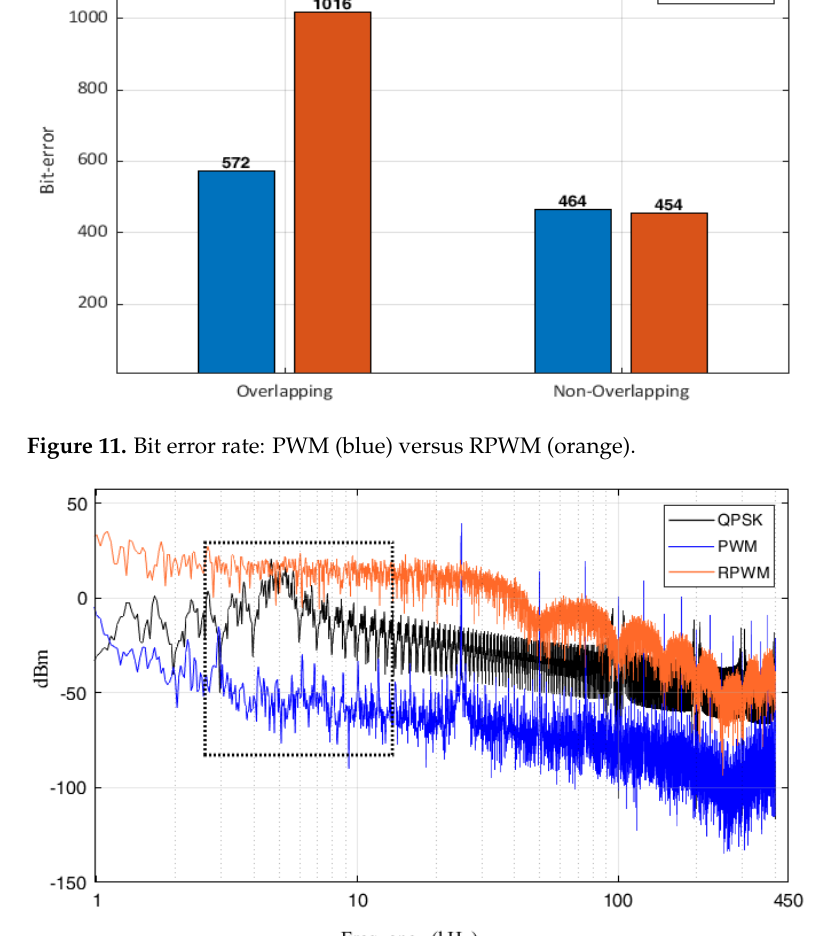
Figure 12. Voltage harmonics at the DC-DC converter output: PWM versus RPWM (25 kHz switching frequency) and frequency spectrum of QPSK modulated signal. The x-axis is in logarithmic